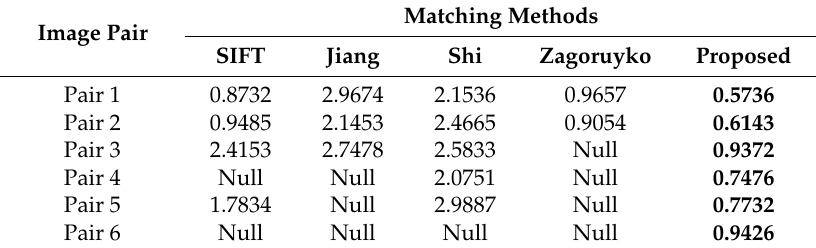
Table 4. RMSE values of each method for remote sensing images with complex background variations.